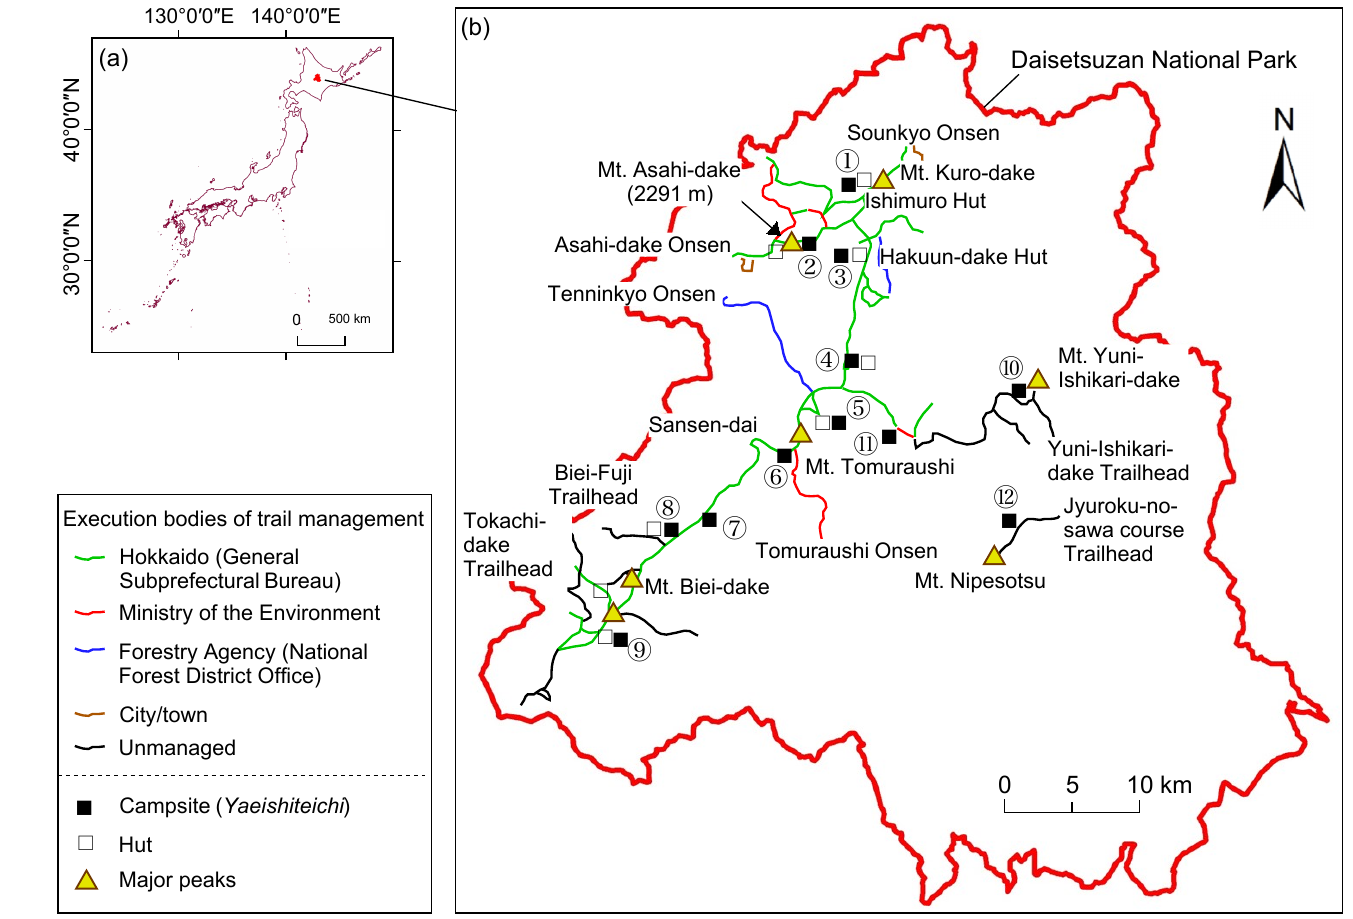
Figure 1. Study area of Daisetsuzan National Park ( a ) and the campsite distribution in the park area ( b ). See Table 1 for the names of the campsites 1 (cid:13)